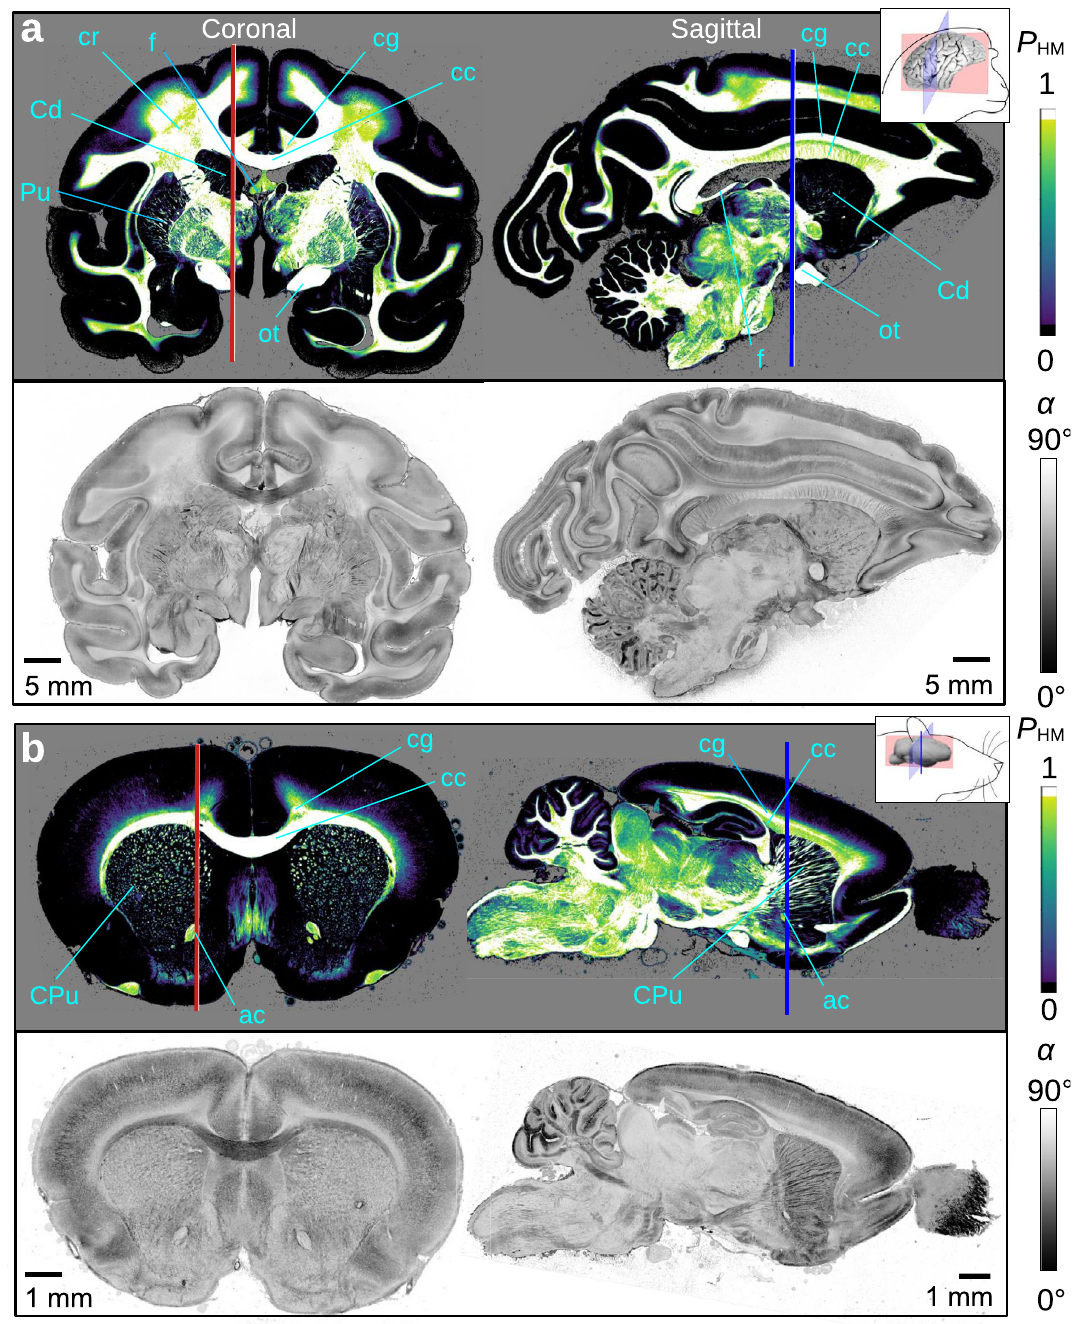
Figure 7. HM-probability and inclination maps of coronal and sagittal sections of vervet monkey brains ( a ) and rat brains ( b ). The upper images show the HM-probability maps P HM computed from 200 iterations and 25% sample size. The lower images show the inclination maps α computed from the linearly combined formulas of LM- and HM-regions (Eq. 8), using the HM-probability value. The red and blue vertical lines indicate the approximate position of the sagittal and coronal section plane in the complementary brain section. Selected anatomical regions are labelled for reference (ac = anterior commissure, cc = corpus callosum, cg = cingulum, cr = corona radiata, f = fornix, ot = optic tract, Cd = caudate nucleus, CPu = caudate putamen, Pu =